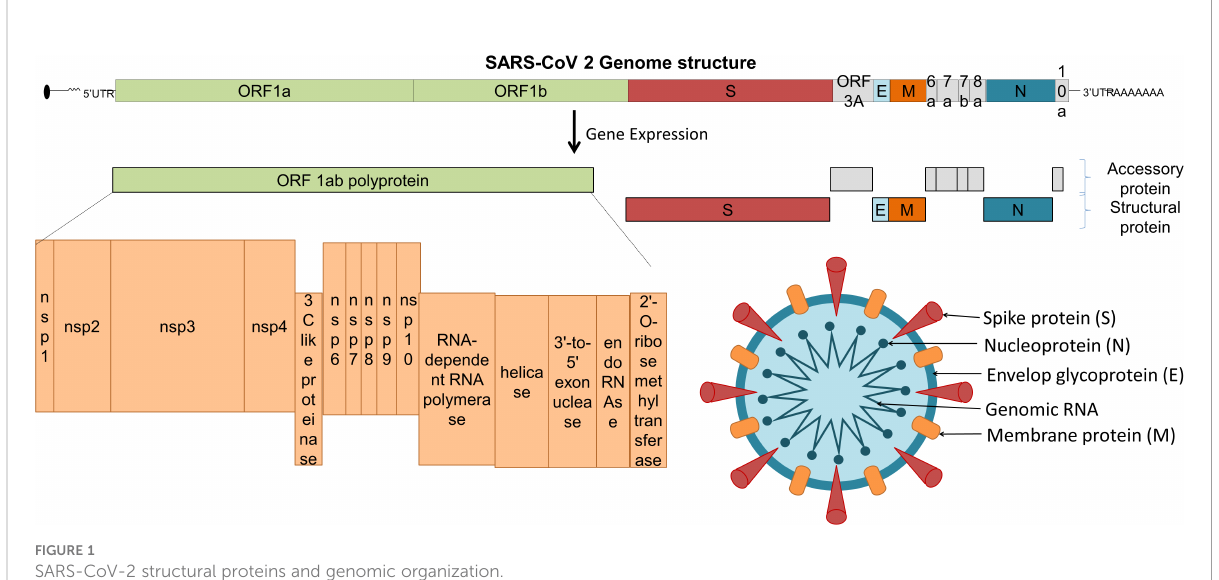
FIGURE 1 SARS-CoV-2 structural proteins and genomic